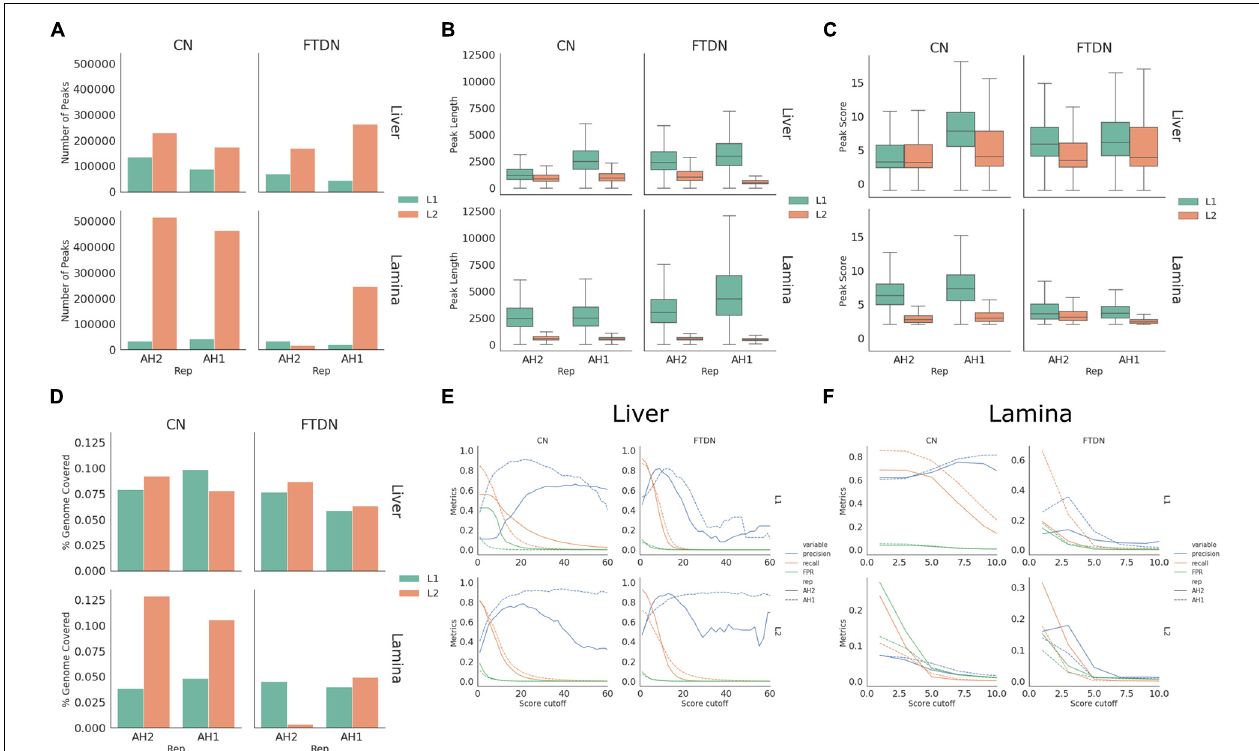
FIGURE 3 | HMMRATAC peak calling statistics. (A) Number of peaks, (B) peak length distribution, (C) peak score distribution, and (D) percent of genome covered by peaks for each library. (E,F) Peak metrics assessed using ChIP-seq dataset in liver (E) and lamina (F) libraries.